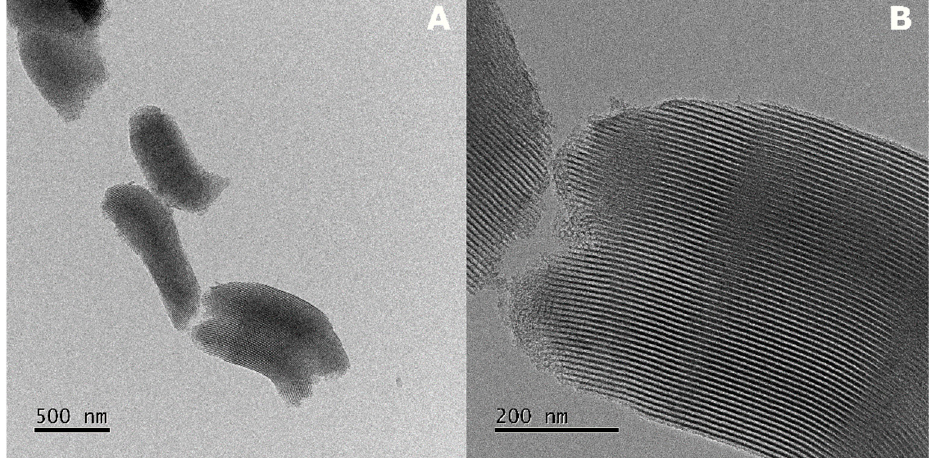
Figure 1. Morphology of SBA-15 nanoparticles. ( A ) TEM image of the irregular shape of particles. ( B ) TEM image of a particle with ordered channels throughout its entire structure. ( B ) TEM image of a particle with ordered channels throughout its entire